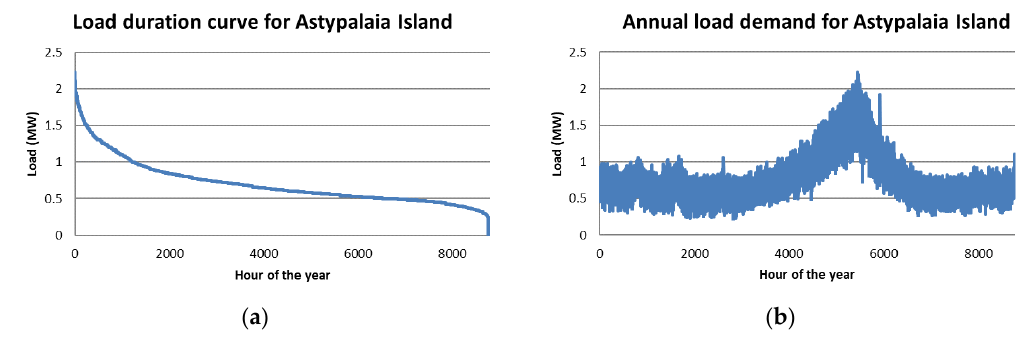
Figure 1. Net load on Astypalaia Island for the year 2014: ( a ) load duration curve; ( b ) annual load demand.